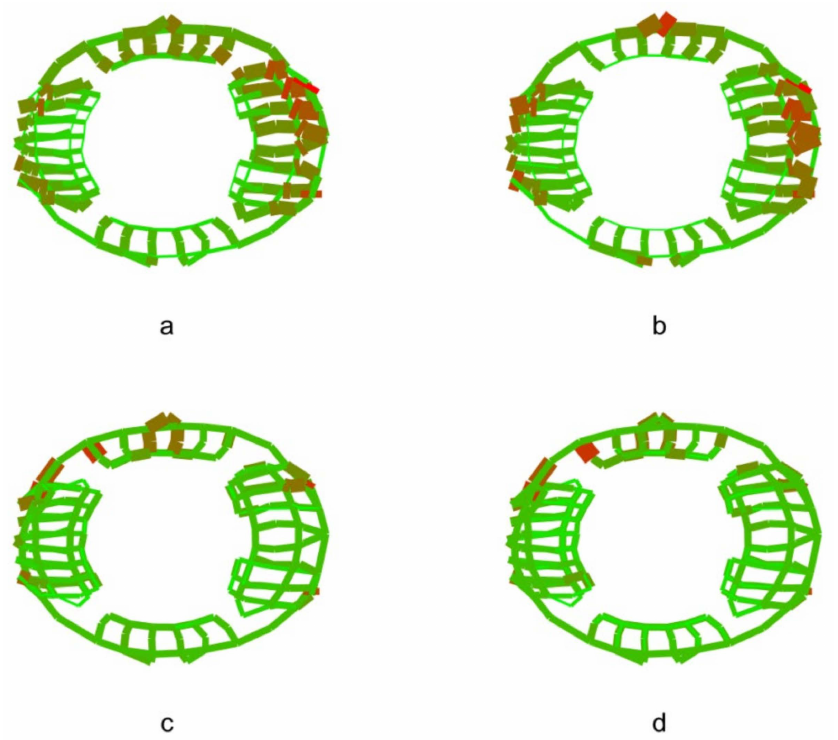
Figure 9. Two-dimensional evacuation routes. ( a ) ACO. ( b ) HMERP. ( c ) HDAFSA. ( d ) AFSAP.